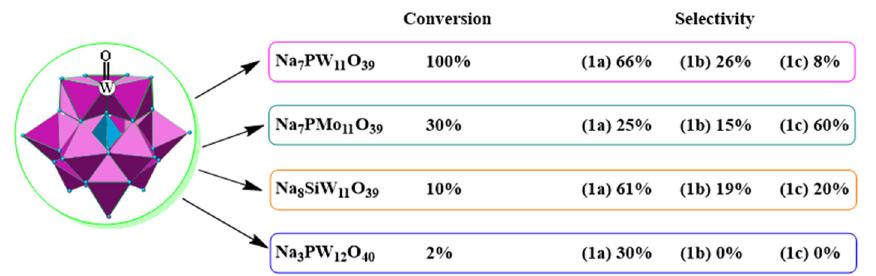
Scheme 13. Main products of Na 7 PW 11 O 39 -catalyzed linalool oxidation with hydrogen peroxide (adapted from ref. [30]).